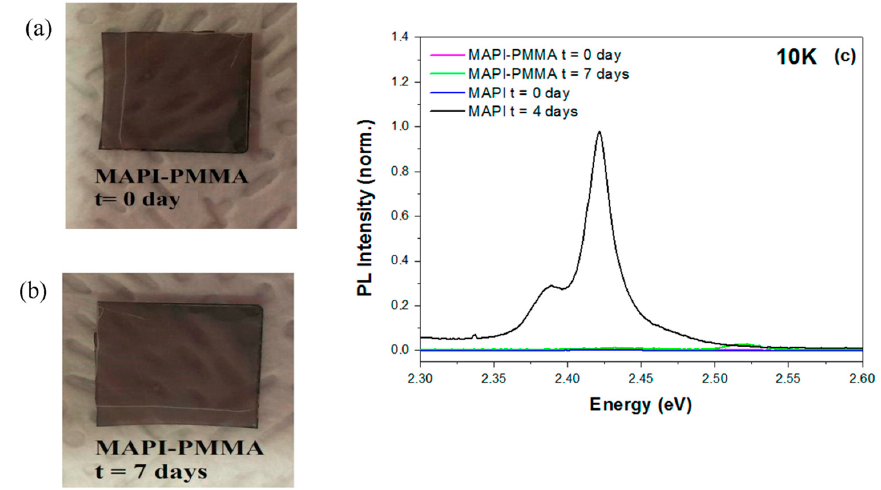
Figure 6. Photographs at ( a ) t = 0 day; ( b ) t = 7 days of a 800 nm thick MAPI layer overcoated with a 200 nm thick PMMA layer (called MAPI-PMMA); ( c ) PL spectra (excitation at 3.815 eV) in the 2.3–2.6 eV range for MAPI-PMMA at t = 0 and MAPI-PMMA at t = 7 days, MAPI t = 4 days is recalled